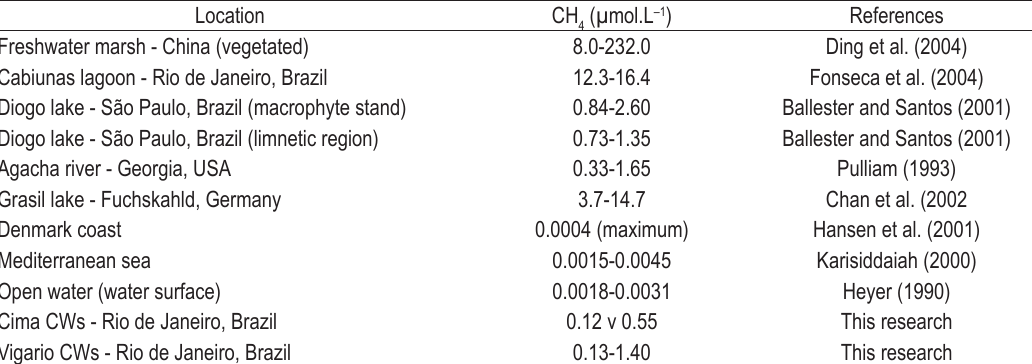
Table 5. Methane concentration in waters for others aquatic ecosystems.